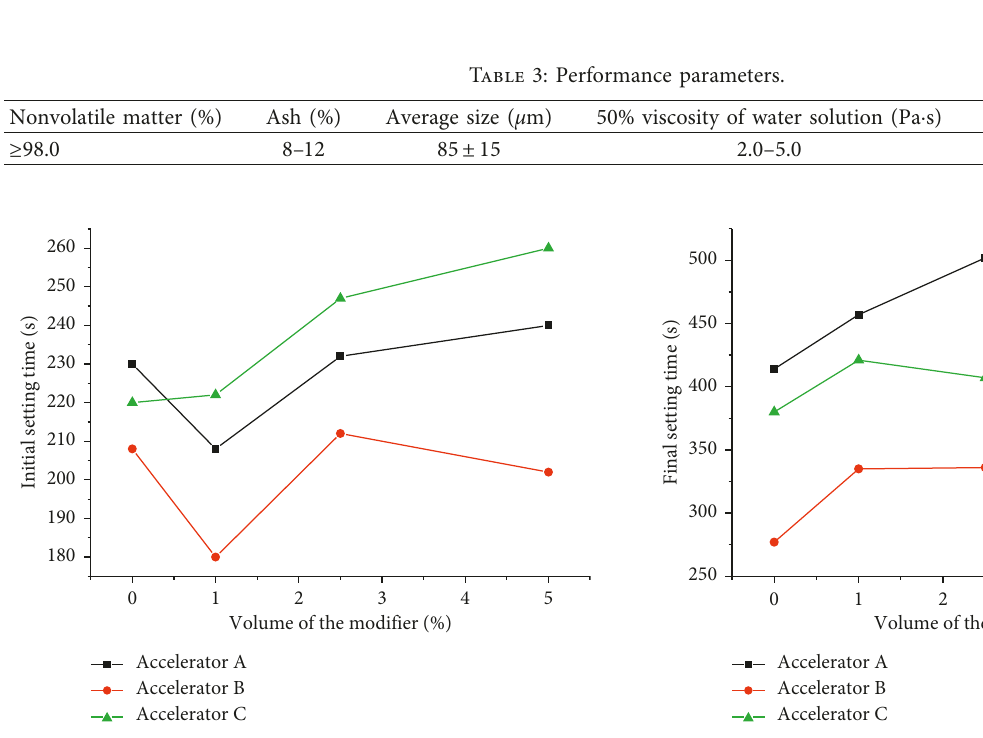
Figure 2: The effect of SWF volume on initial setting time. Figure 3: The effect of SWF volume on final setting time.